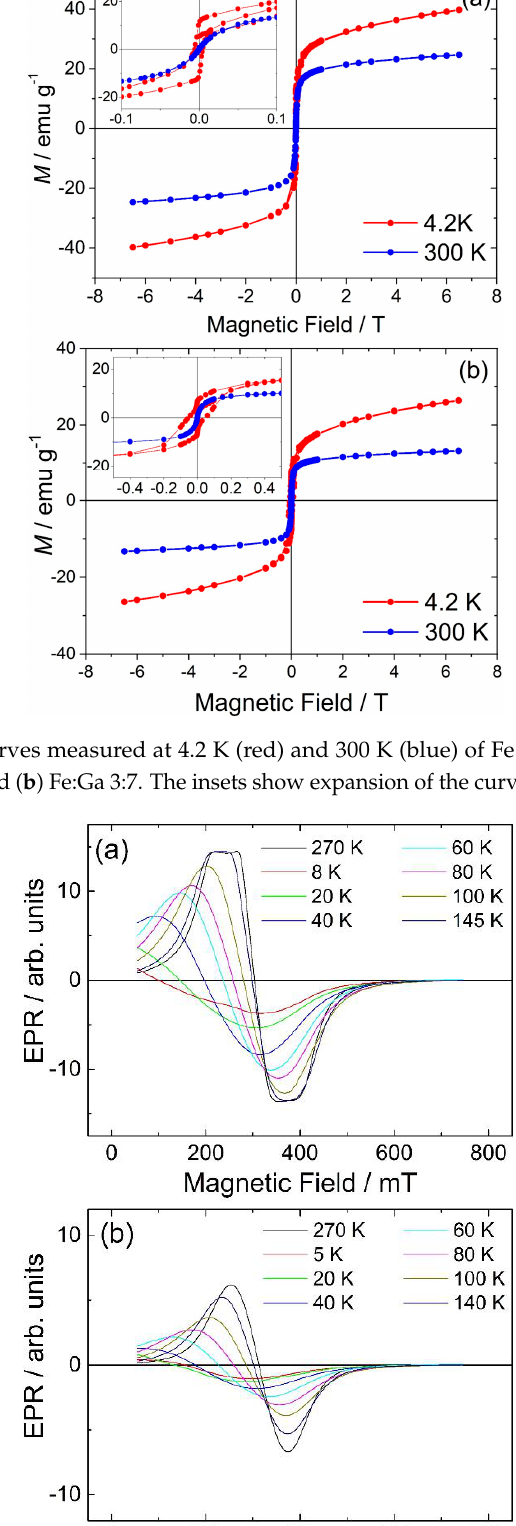
Figure 9. Electron paramagnetic resonance (EPR) spectra measured at 9.44 GHz as a function of temperatures for Fe substituted γ -Ga 2 O 3 ( a ) Fe:Ga 1:1 and ( b ) Fe:Ga 3:7.